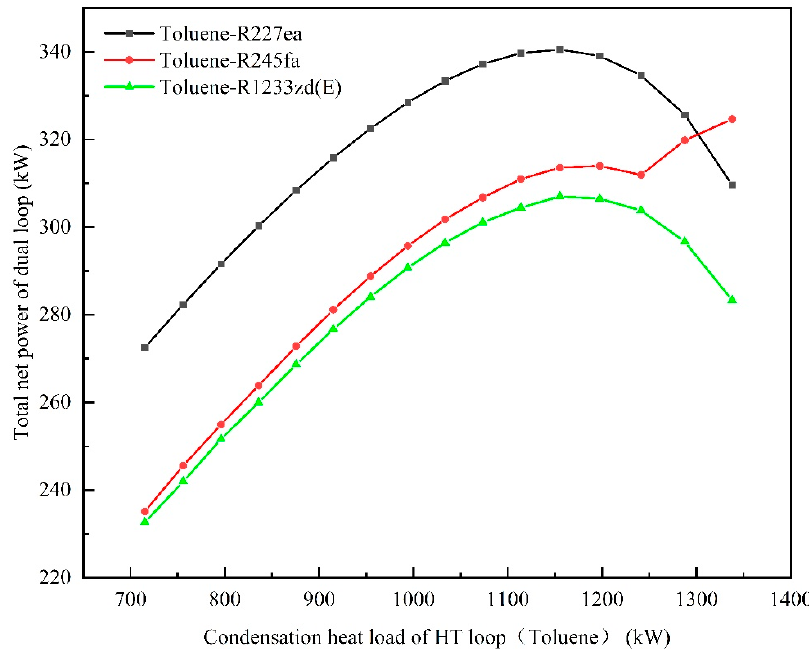
Figure 17. Total net power of the dual loop with toluene as the HT loop’s working fluid. Table 3. The optimal numerical setup for a dual-loop